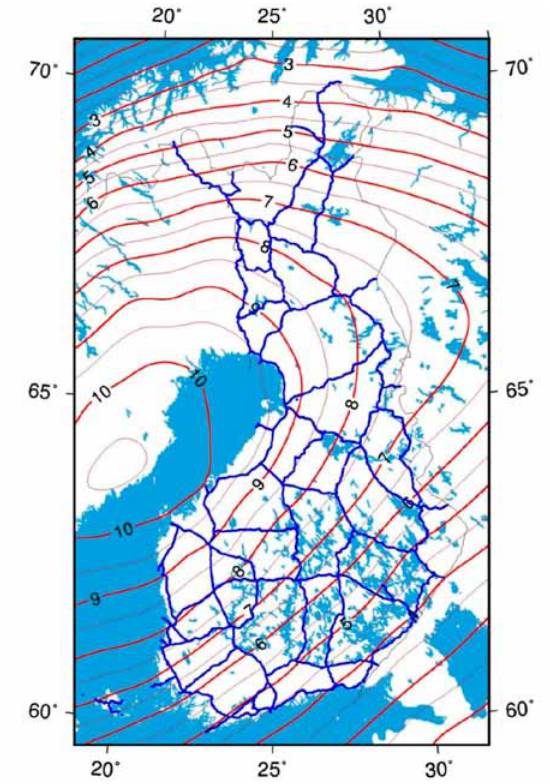
Fig. 1. Postglacial rebound in Finland (red contours), in mm/year. The contours are from the Nordic uplift model NKG2005LU (Vestøl 2005; Ågren, Svensson 2007), which is relative to the Baltic mean sea level 1892–1991. The model is adjusted in vertical direction to fit the GNSS based absolute uplift rate by Lidberg et al. (2007). The first order levelling network (N2000) is in blue